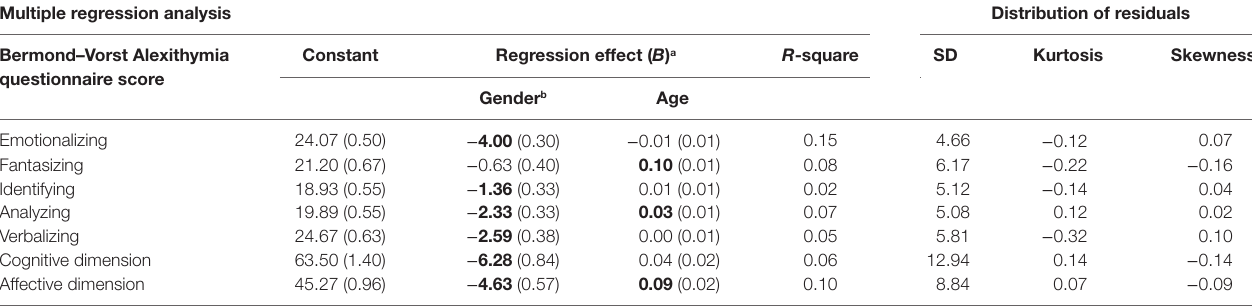
TaBle 7 | Multiple regression analysis predicting first-order scores or second-order scores from age and gender, and distribution of the residuals. Multiple regression